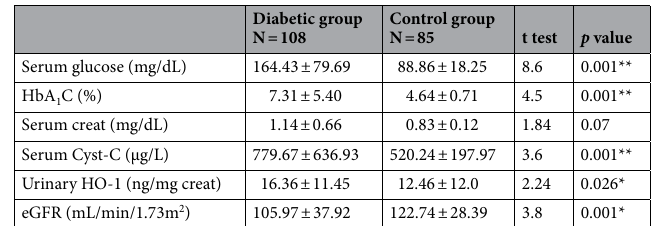
Table 2. Levels of biochemical parameters in diabetic and control groups. **High significant p < 0.001, *significant at p < 0.05.